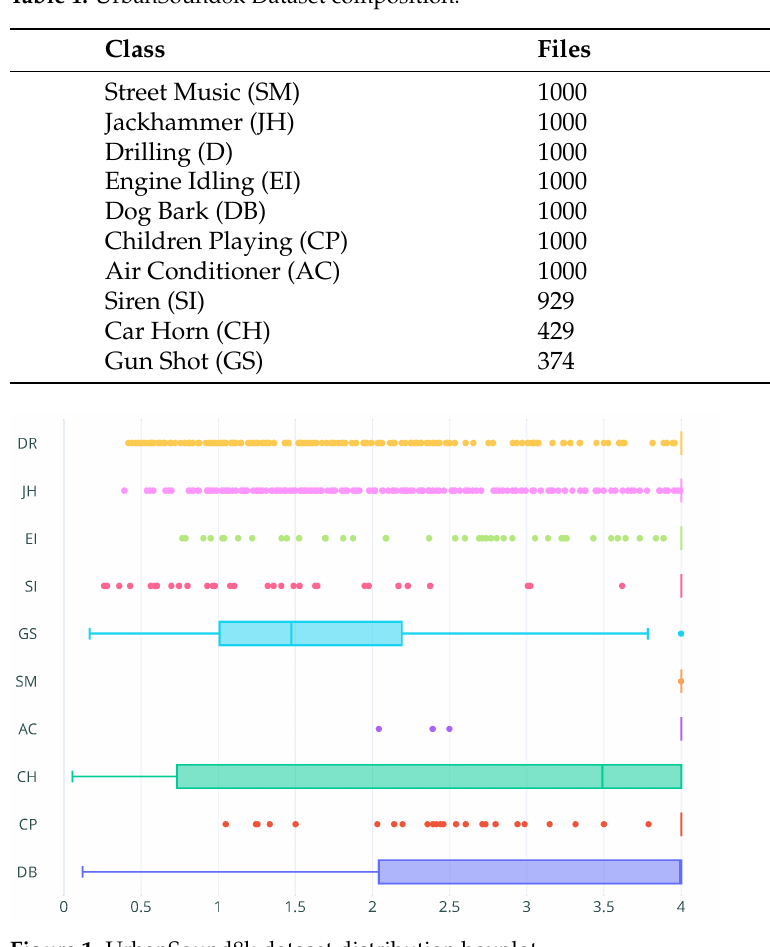
Figure 1. UrbanSound8k dataset distribution